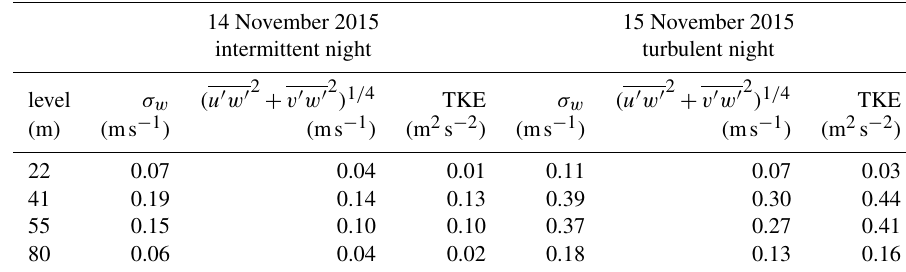
Figure 1. Time series of horizontal ( a and c ) and vertical (e) wind components, temperature perturbation from the 20:00LT value at 41m (b) , and CO 2 and O 3 (d) and water vapor (f) concentrations for the turbulent night. Table 1. Five-minute turbulence statistics averaged for each night analyzed in Sect.